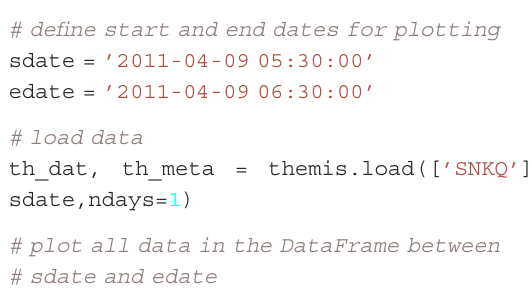
TABLE 4 Example metadata returned by the load